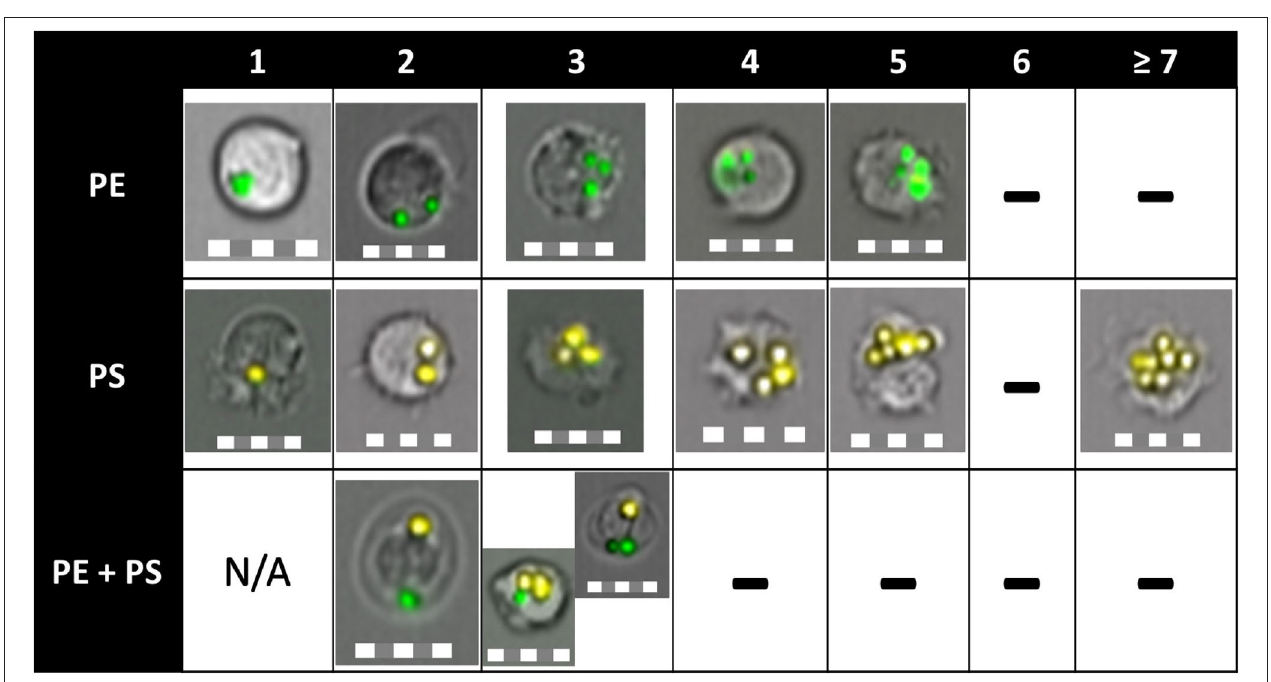
FIGURE 4 | of HK cells to microplastic (50 mg/L). Phagocytic ability of DI (A,B) , blood (C,D) , and HK (E,F) cells exposed to the medium (left) and the high (right) MP concentrations. The lines show the general MP accumulation trends in time. The color codes for the MPs are: PE (green), PS (yellow), and PE + PS (red). Different letters above the lines represent statistical differences between polymer types at each time point. Asterisk and dot represent statistical differences between time points of a polymer type; *shows that there are differences compared to 1h and • shows that there are differences compared to 24h.